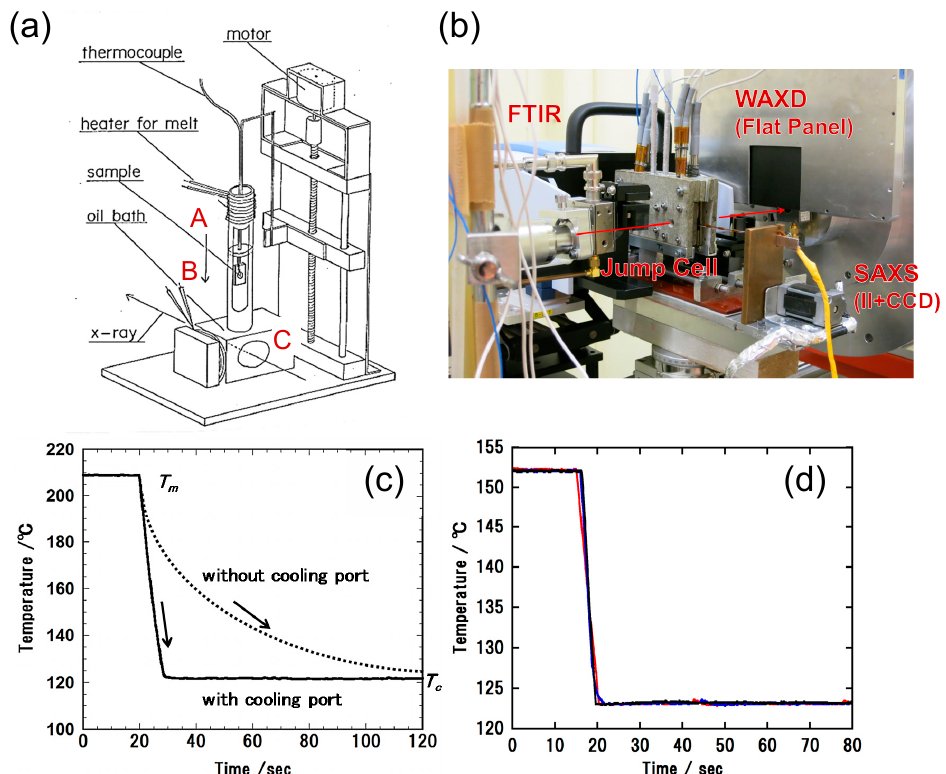
Figure 2. Temperature jump cells. ( a ) Manually operated system (the sample holder is moved vertically) and ( b ) computer-controlled system (the sample holder is moved horizontally from position (A) to (B) to (C)). ( c ) Temperature change in the sample in the temperature jump process with and without the cooling port at position (B) and ( d ) the reproducibility of the temperature change observed for the system ( b ).